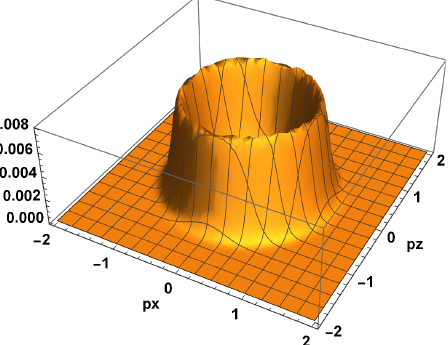
Figure 2. Γ ( p ) / N Γ vs p x and p z in units of ¯ hk 0 , for k 0 σ = 4 and p y = 0. This describes the isotropic emission of a photon with momentum ¯ h k 0 . The atoms, after absorption of a photon with momentum ¯ h k 0 along the z -axis and the subsequent isotropic emission, recoil with a momentum distribution proportional to Γ ( p − ¯ h k 0 ) . Exper- imentally, the column-integrated momentum distribution is observed in time-of-flight im- ages. This leads to defining the projected distribution D y ( p x , p z ) = shown in Figure 3 for k 0 σ = 4. The blob on the left represents the initial momentum distri- bution, in qualitative agreement with the experimental results of Figure 1.